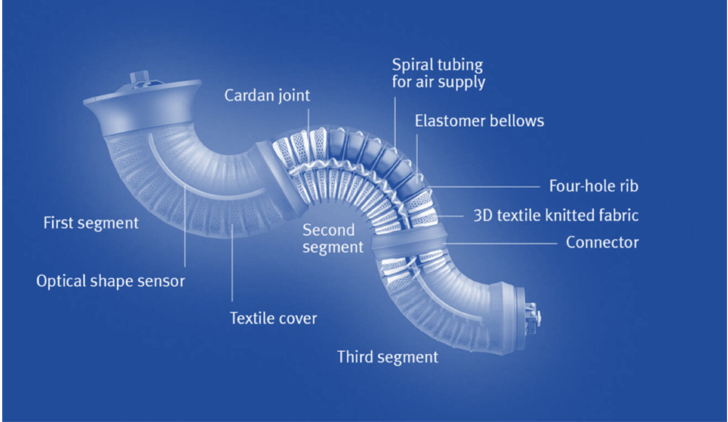
Figure 6. BionicMotionRobot (2017) [87].